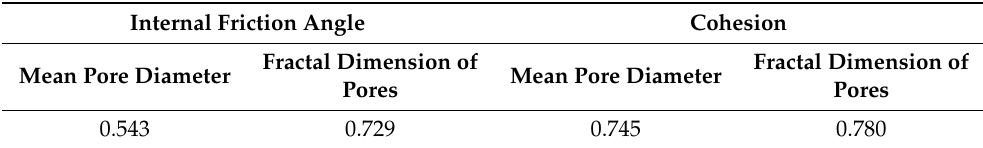
Table 12. Calculated correlation degrees between shear strength indices and microstructural parame- ters of Yili loess samples under drying–wetting cyclic action. Internal Friction Angle Cohesion Fractal Dimension of Fractal Dimension of Mean Pore Diameter Mean Pore Diameter Pores Pores 0.543 0.729 0.745